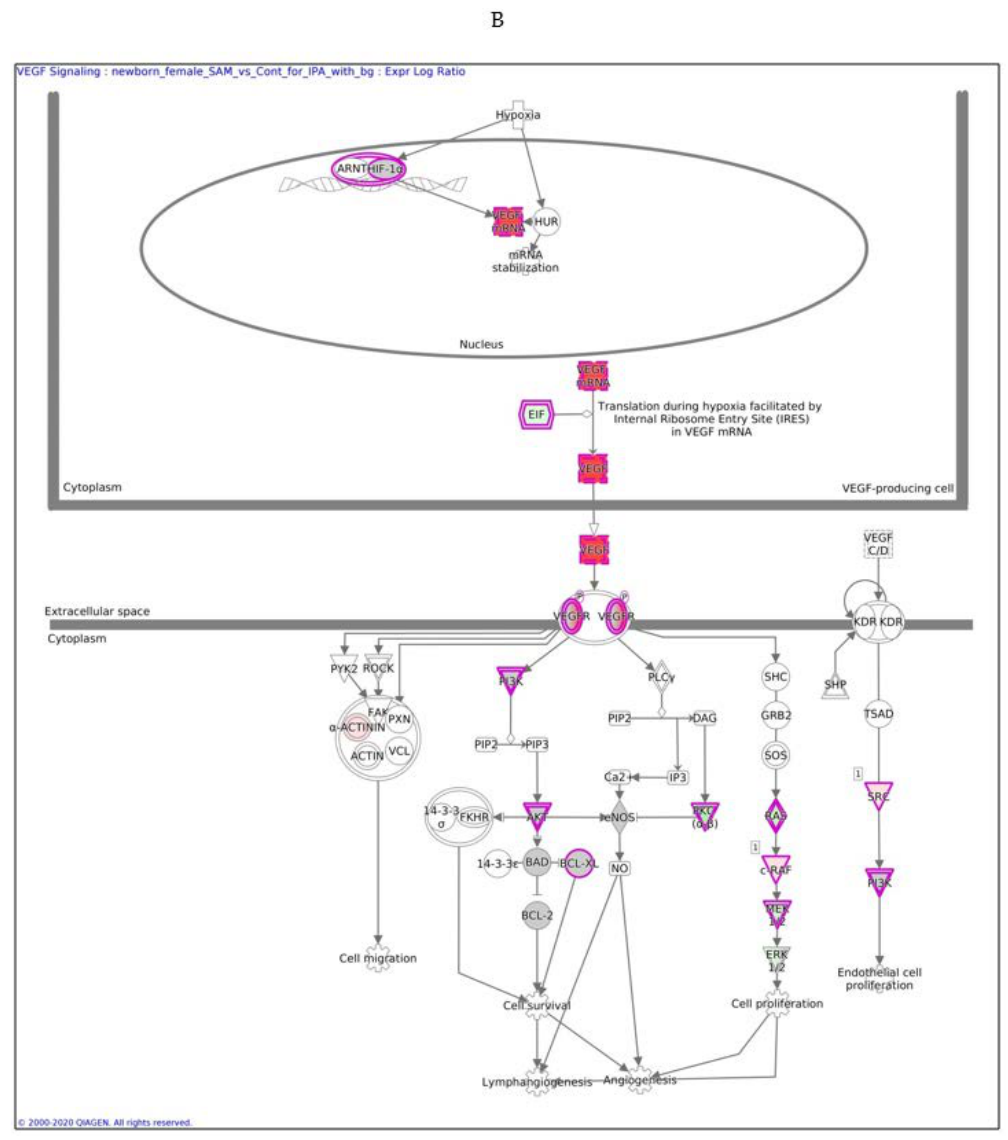
Figure 3 . VEGF signaling pathway in males ( A ) and females ( B ) exposed to SAMe during pregnancy. Ingenuity pathway analysis of differentially expressed genes in mice treated with SAMe administration. Ingenuity Pathway (IPA) Analysis identified the VEGF- a (vascular endothelial growth factor A) signaling pathway as being enriched. The network was generated through the use of IPA (Qiagen, Ingenuity Systems, www.ingenuity.com) on normalized mRNA values measured by Nanostring analysis. Nodes represent molecules in a pathway, while the biological relationship between nodes is represented by a line (edge). Edges are supported by at least one reference in the Ingenuity Knowledge Base. The brightness of color in a node indicates the degree of upregulation (red) or downregulation (green). Nodes are displayed using shapes that represent the functional class of a gene product (Circle = Other, Nested Circle = Group or Complex, Rhombus = Peptidase, Square = Cytokine, Triangle = Kinase, Vertical ellipse = Transmembrane receptor). Edges are marked with symbols to represent the relationship between nodes (Line only = Binding only, Flat line = inhibits, Solid arrow = Acts on, Solid arrow with flat line = inhibits and acts on, Open circle = leads to, Open arrow = translocates to). The di ff erence between Figure 3A,B is in the intensity of the colors, which show the level of the expression of a specific gene. For clarity, the data are shown in Table 5 (males) and Table 6